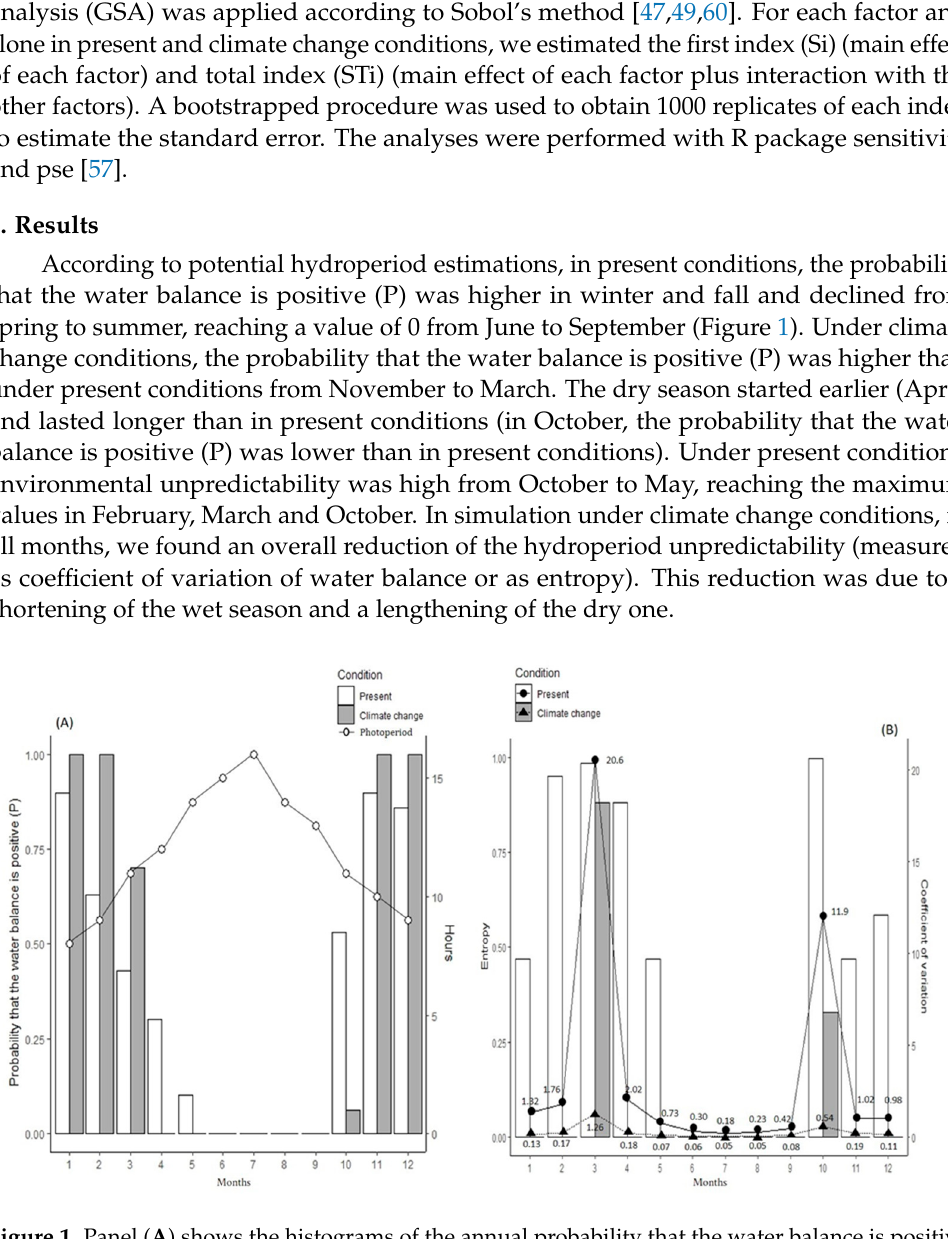
Figure 1. Panel ( A ) shows the histograms of the annual probability that the water balance is positive (P) under 2 different climatic conditions: present (white) and climate change (grey). The photoperiod of the Po plain was reported as lines and circles. Panel ( B ) shows the measures of environmental uncertainty: left y-axis is referred to the histograms of the entropy in present condition (white) and climate change (grey). The right y-axis is relative to coefficient of variation (CV) in 2 climatic conditions: present (continuous line and circle) and climate change (dashed line and